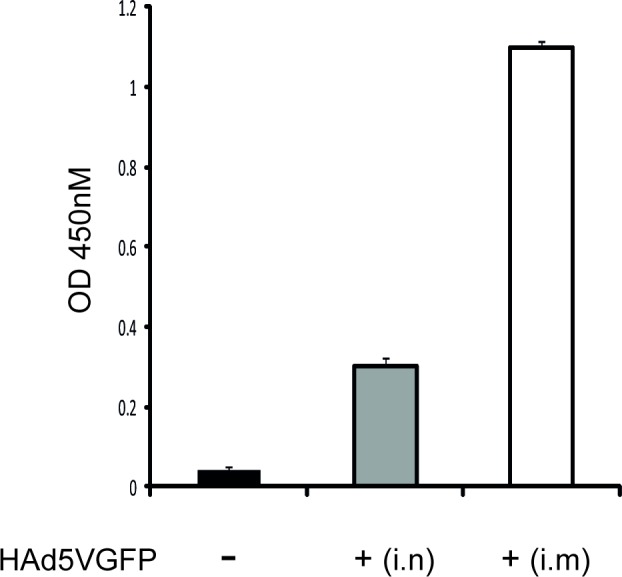
Humoral immune responses to HAd5VGFP detected in serum samples of mice immunized with HAd5VGFP by i.n. or i.m. inoculation route.Mice were immunized with HAd5VGFP (107 pfu/animal) by i.n. or i.m. route. One week later, sera were collected and the anti-HAd5VGFP antibodies were measured by ELISA. The control group was injected with PBS (-). The graph shows one of two independent experiments with at least 4 mice per group. Bars represent mean values +/- SD. (-) mice non-immunized with adenovirus; i.n.–intranasal immunization route; i.m.–intramuscular immunization route; s.c.–subcutaneous immunization route.